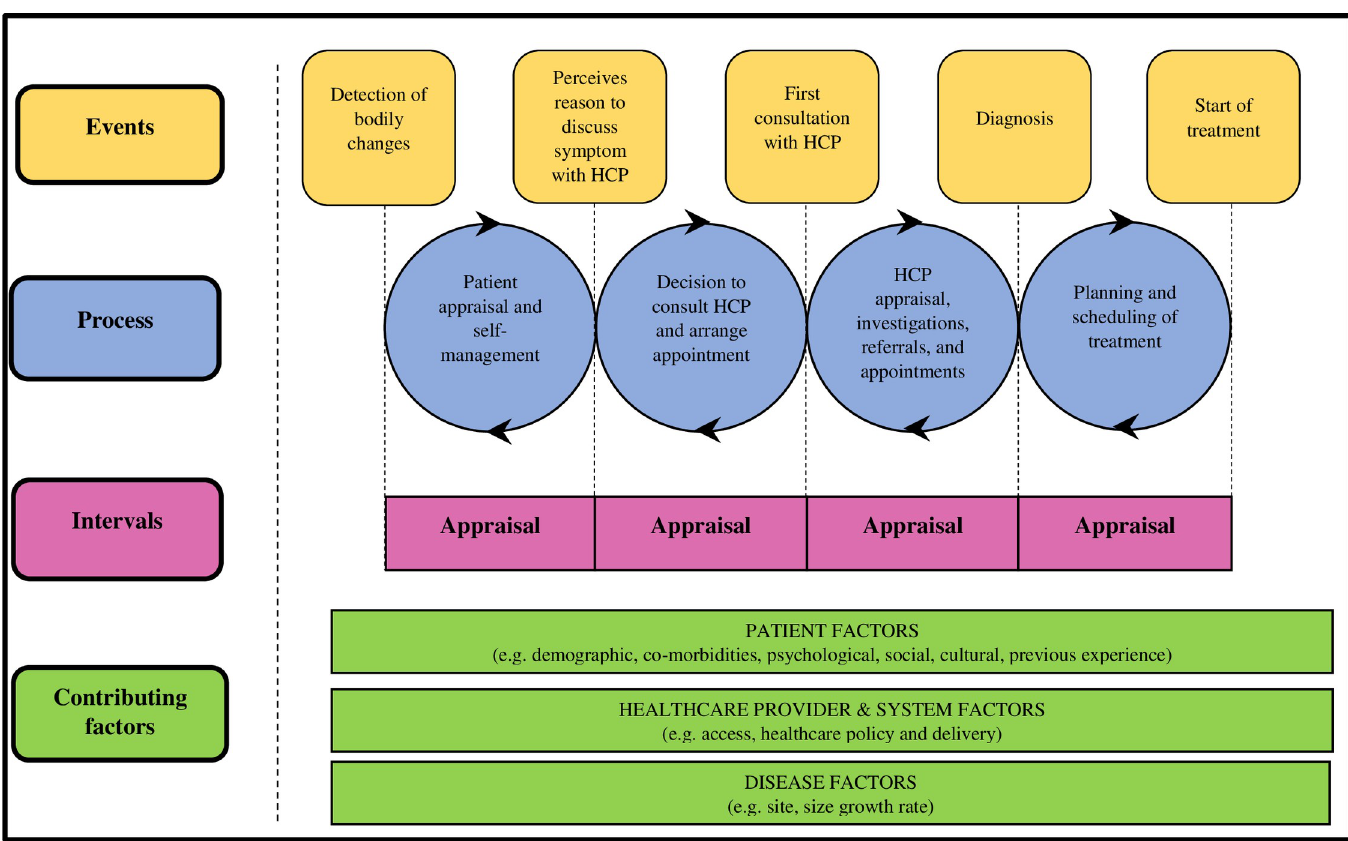
Fig 1. Walter’s Model of Pathways to Treatment (reproduced with